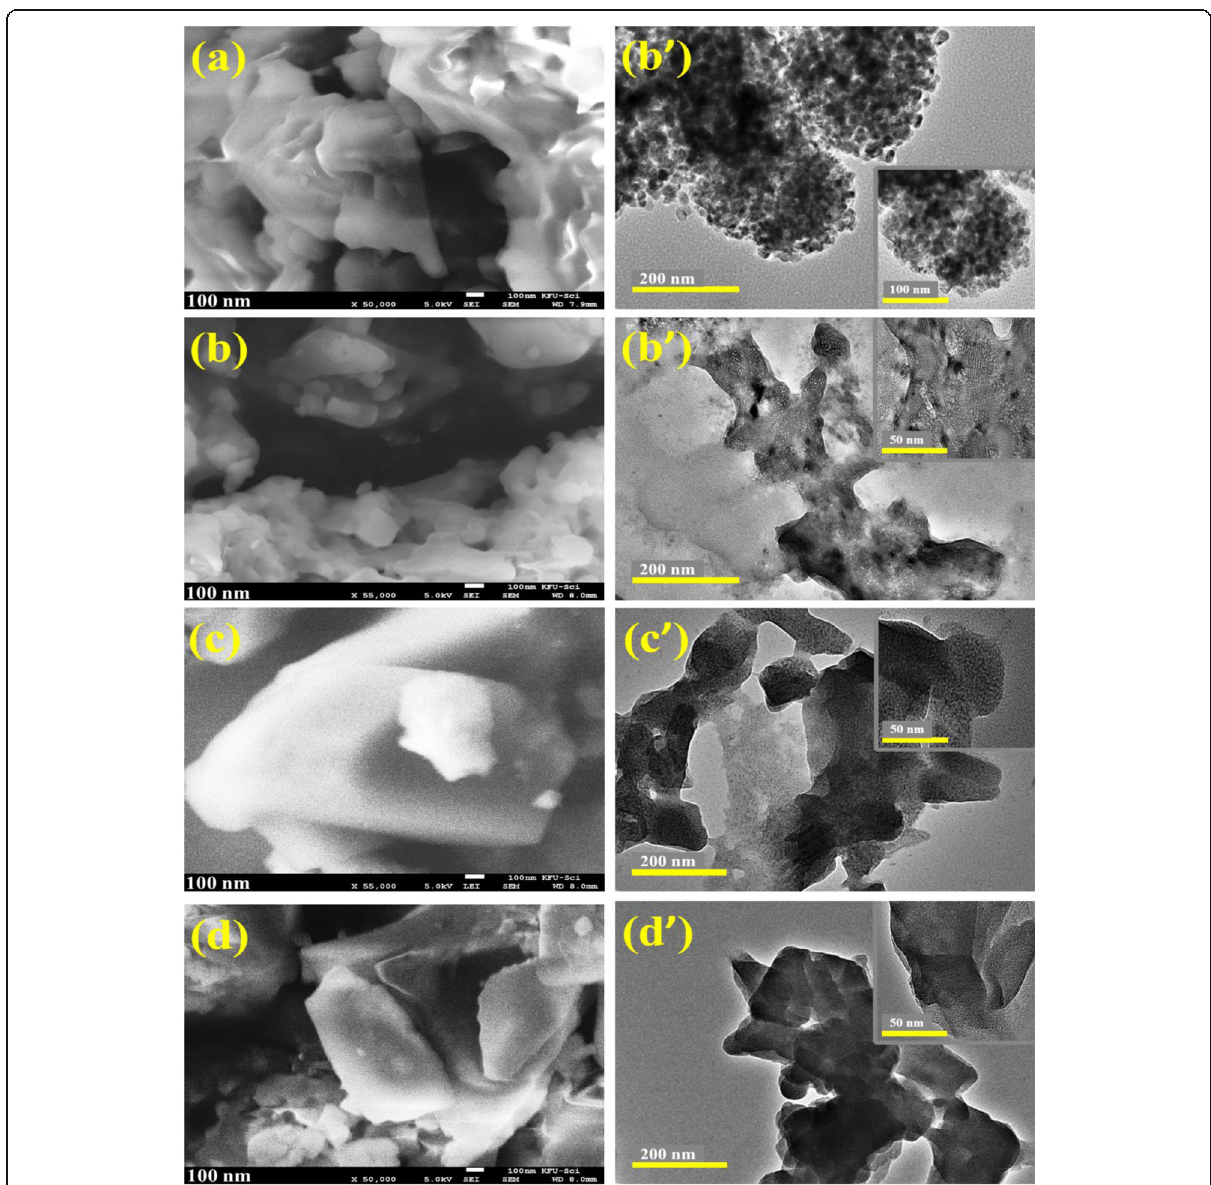
Fig. 6 a , a ’ FE-SEM and HR-TEM images of pure BN-NS. b – d FE-SEM of (2.5, 7.5, and 10 wt%) doped BN-NS. b ’ – d ’ HR-TEM of (2.5, 7.5, and 10 wt%) doped BN-NS (inset 50